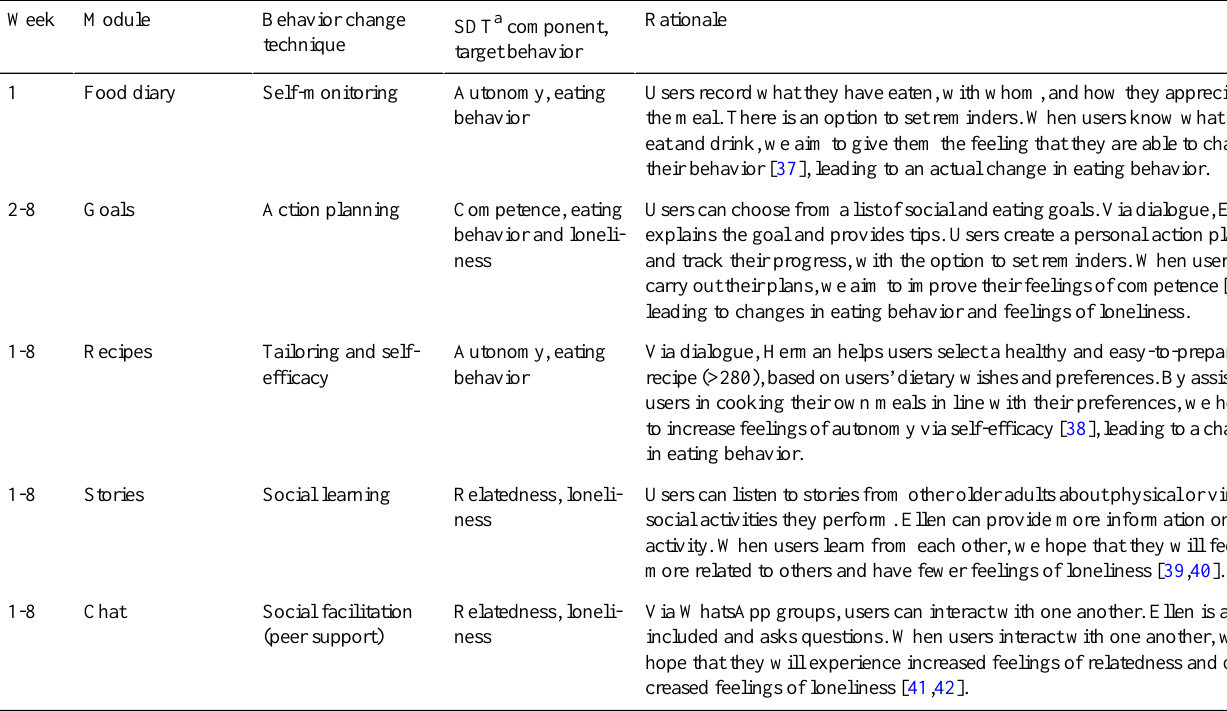
Table 2. The modules of the PACO